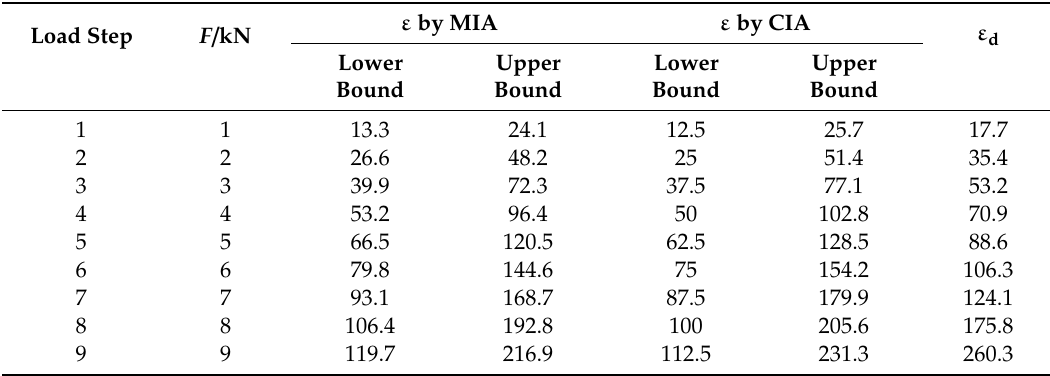
Table 1. Strain predictions of the numerical beam.